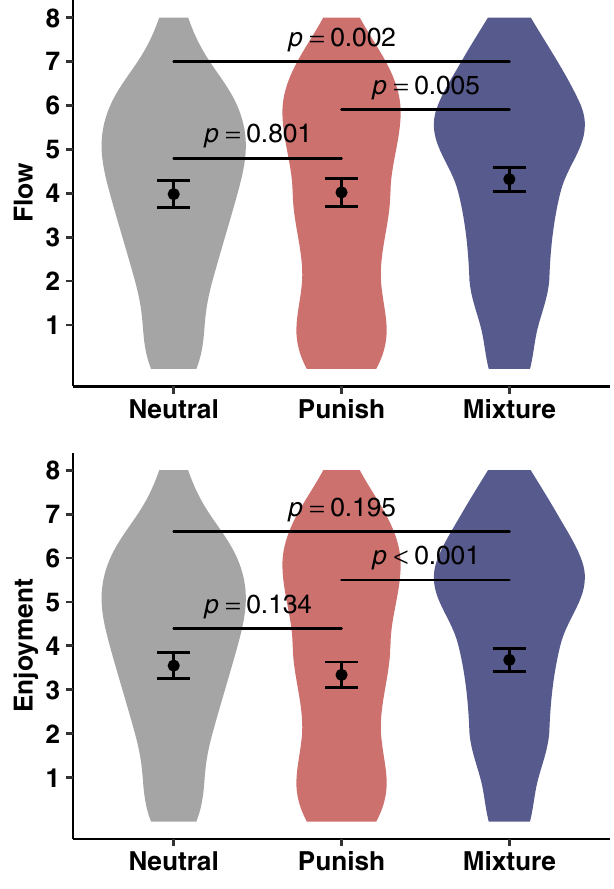
Fig. 7 Results of experiment 3. Effect of game on fl ow and enjoyment in experiment 3. Points denote means and error bars represent 95% CIs. Statistics are derived from LMMs (two-sided) performed over 479 observations across 244 participants. No corrections for multiple comparisons were